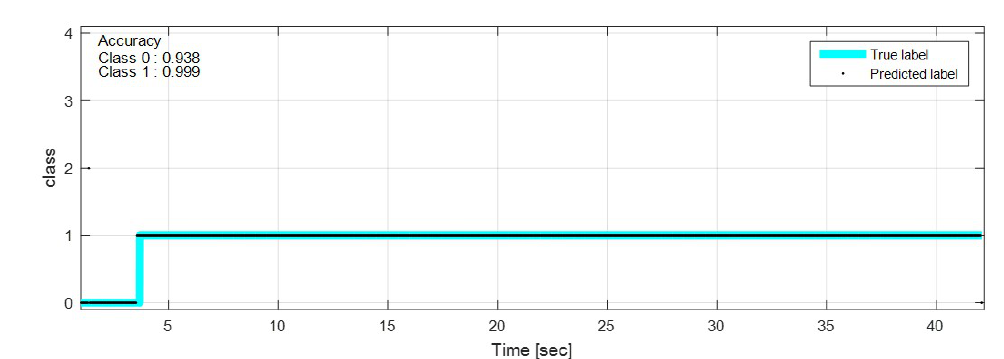
Figure 14. Prediction result on sinusoidal road, 50 km/h.